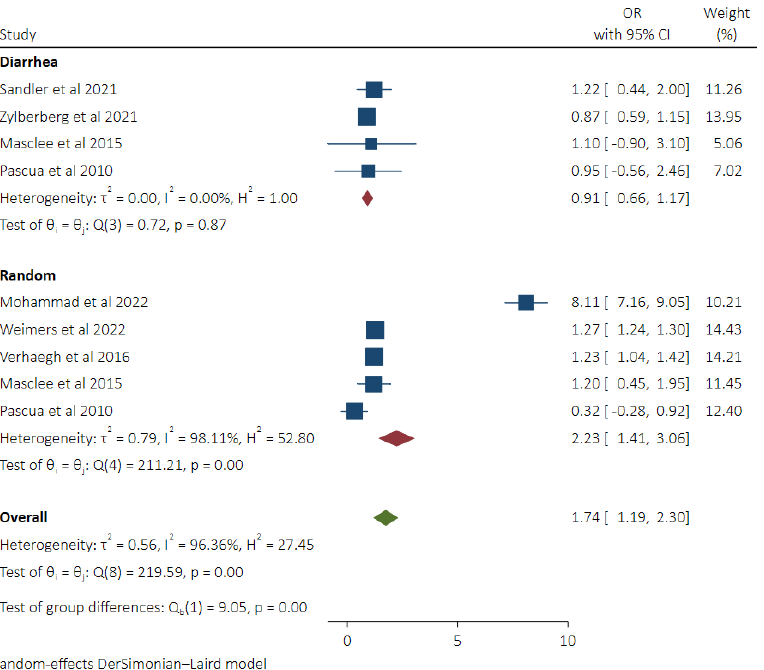
Figure 5. Pooled odds of MC in Statin users with subgroup analysis based on control groups (Diar- rhea vs. Random Control) [8,9,17 – 19,21,22].